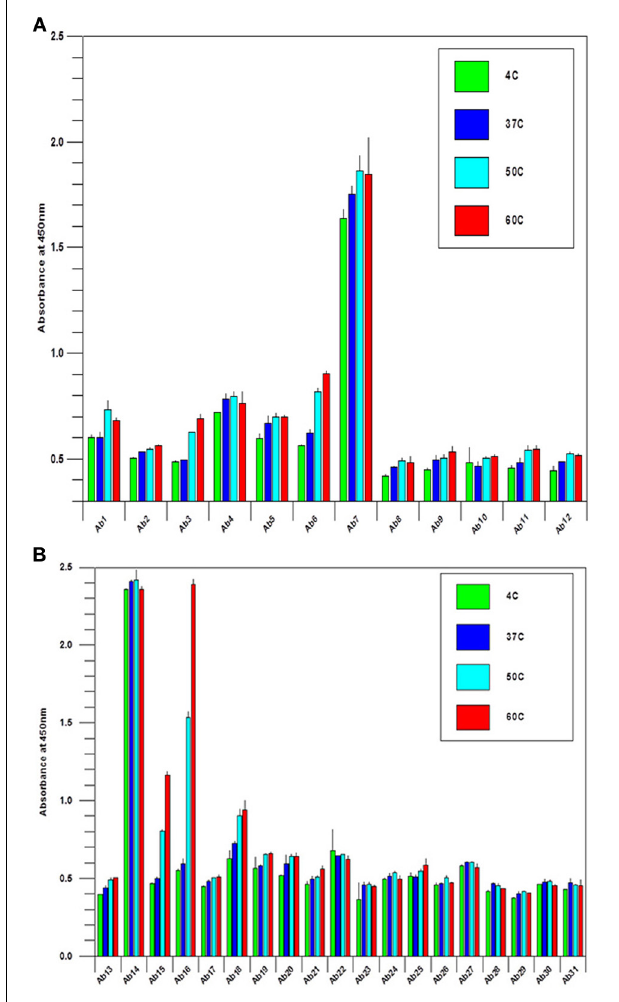
FIGURE 4 | (A) Stability testing of mAbs under clinical development, the variable region. A mAb under clinical development was treated at different temperature as indicated overnight at 1mg/ml, and the samples were diluted to 5 μ g/ml to test the surface epitope exposure for the whole molecule. (B) Stability testing of mabs under clinical development, the constant region. the condition is the same as in (A) except the testing are for the mAb constant regions.